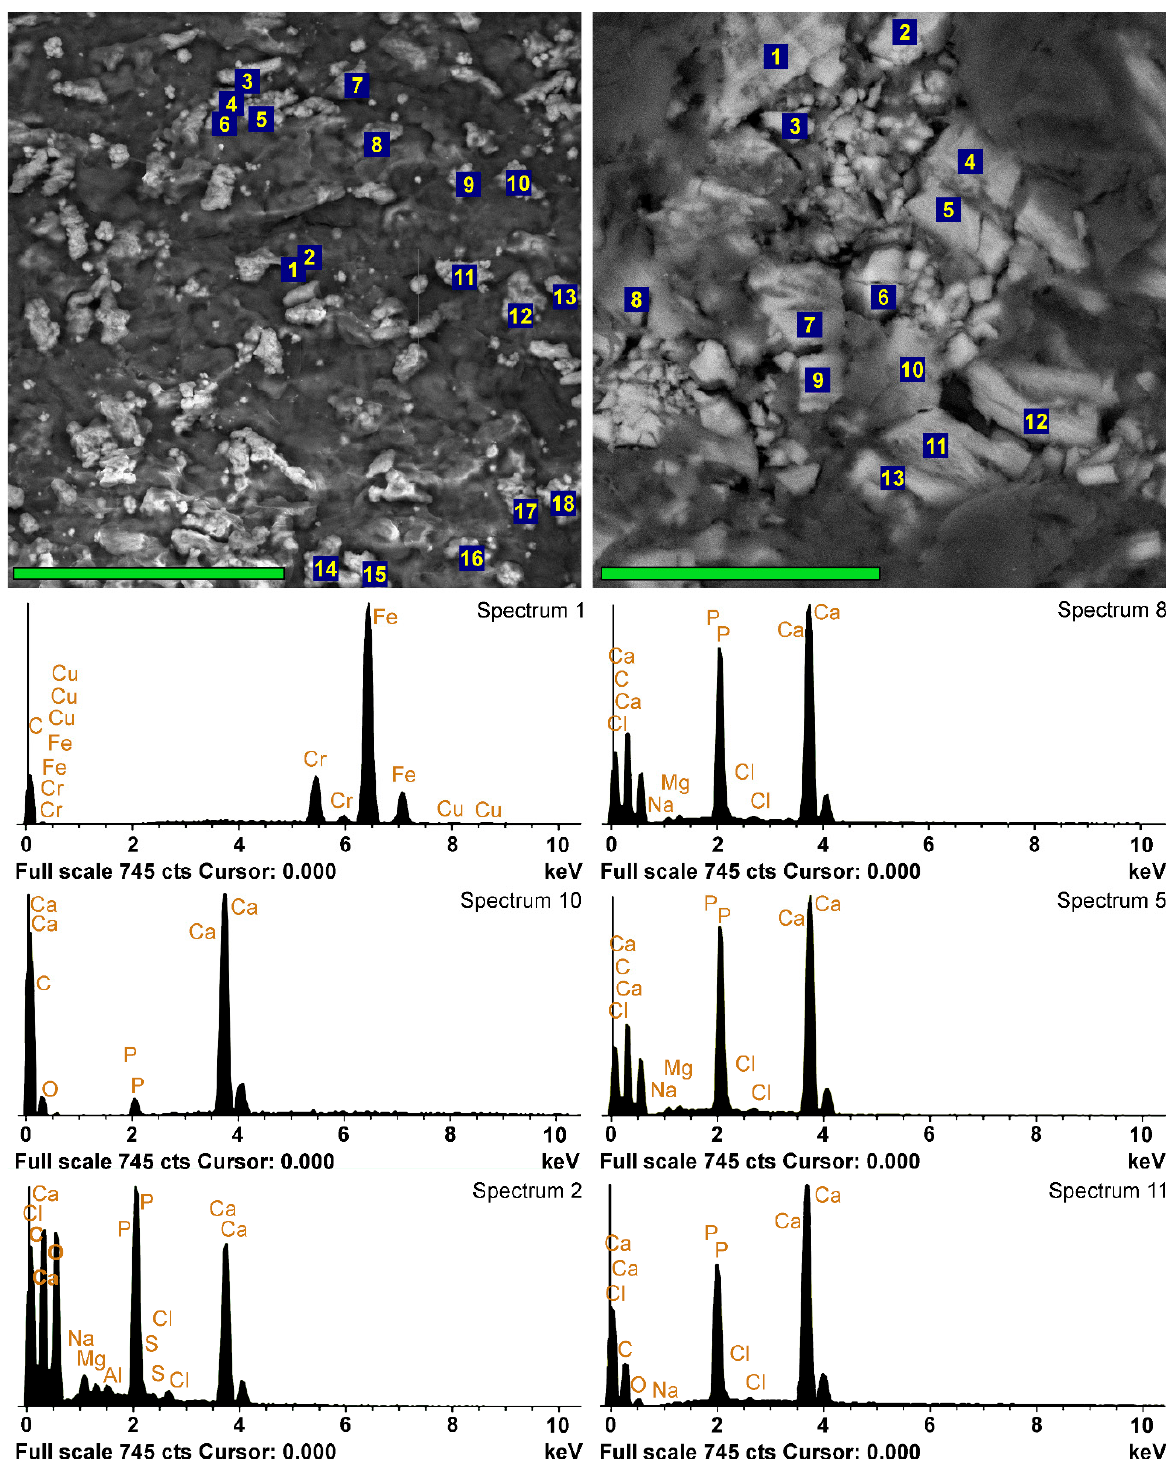
Figure 3. EDS analyses of the implants 10 days after implantation. SEM images in back-scattering electrons and EDS spectra of DE-Ve surface (left column, scale bar 80 µm) and cross-section (right column, scale bar 40 µm). Left spectrum 1 belongs to the external particle; spectrum 10 is hypothetically obtained from a carbonate-apatite deposit with a high content of CaCO 3 ; all the other spectra belong to calcium phosphate with di ff erent Ca/P ratios.